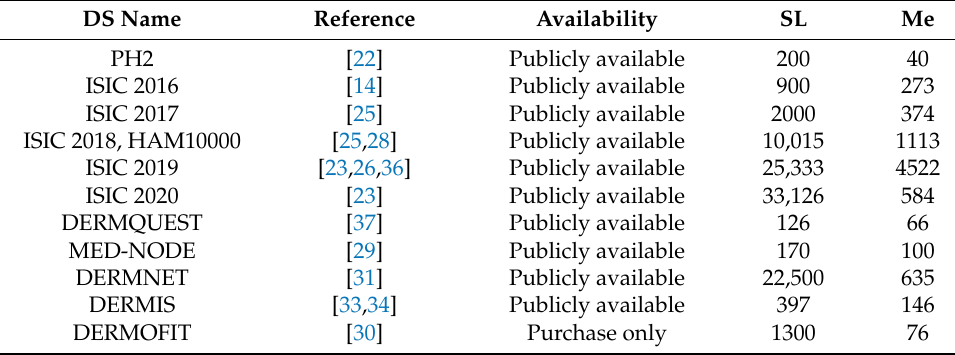
Table 2. Skin lesions DSs frequently used in Me